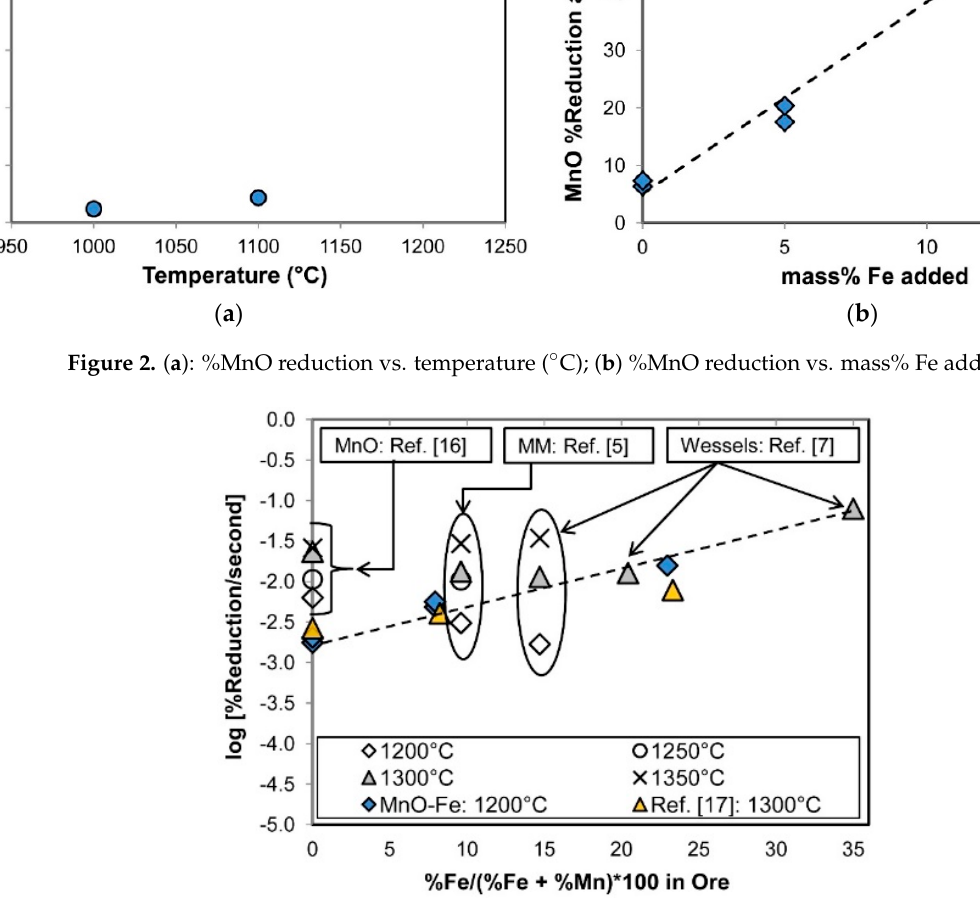
Figure 3. Reduction rates vs. iron content (MnO = pure MnO; MM = Calcined Mamatwan ore; Wes- sels = Wessels ore): (Rankin and Van Deventer [16]: − 250 + 180 µm MnO and − 180 + 125 µm graphite; Eric and Burucu [5]: − 420 µm Calcined Mamatwan Ore and − 43 µm graphite; Akdogan and Eric [7]: − 297 µm Wessels Ore and − 44 µm graphite; Kim and Jung [17]: − 250 + 63 µm MnO and − 5 µm graphite and − 150 µm Fe).